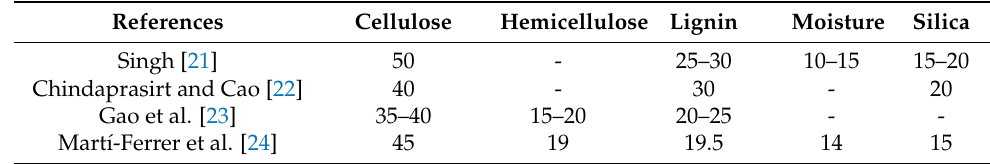
Table 1. Basic rice husk composition.